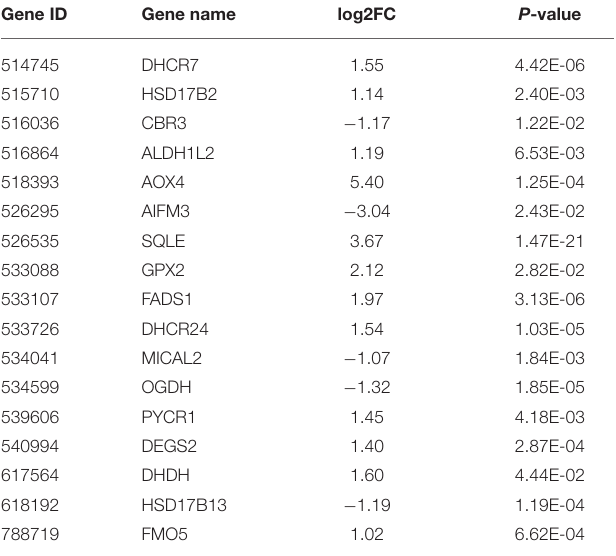
( Figure 4 ). The overall expression pattern of genes in the Cd- treated group was quite different from that of the control group, and the three samples within the same group showed similar expression patterns. This indicates that the samples from both groups were reproducible, demonstrating that the derived data were